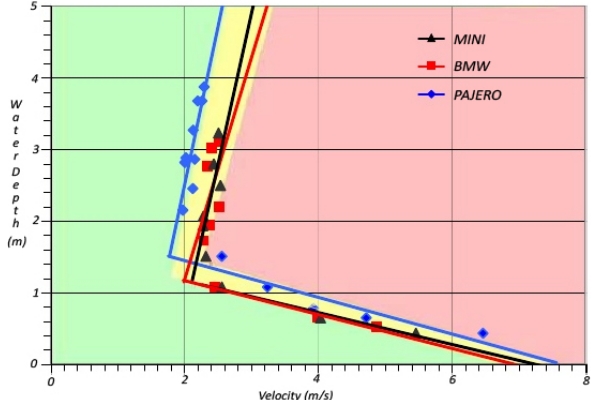
Figure 4. Critical threshold values of hydraulic instability for spe- cific vehicles (taken from Teo et al.,